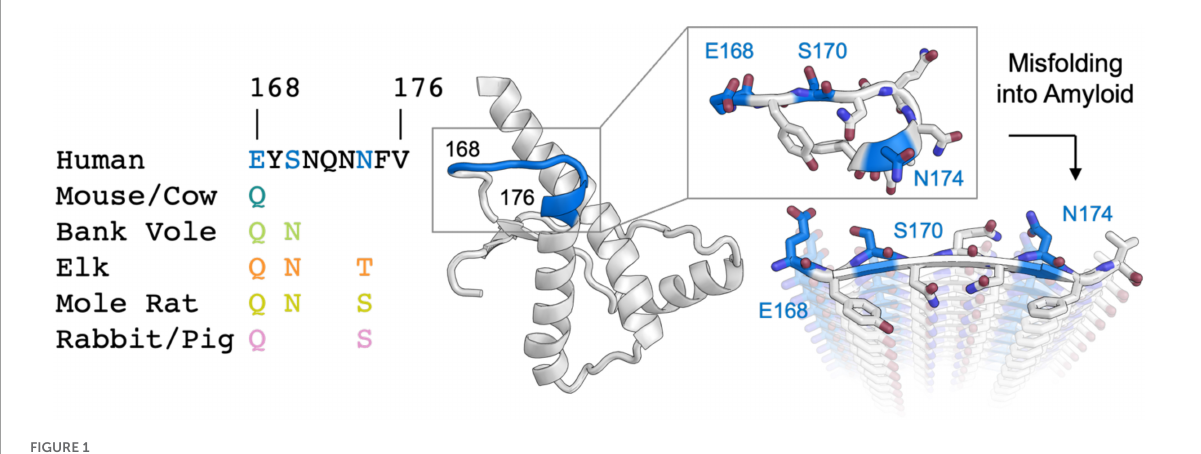
FIGURE1 Analysis of sequence variability in polar residues of the β 2 α 2 loop of the mammalian prion protein. The β 2 α 2 loop of mammalian prions (left) takes on a loop structure in PrP C (center and top right) but misfolds into a beta sheet amyloid conformation (bottom right) . Residues that vary between mammals (168, 170, and 174) are colored. Human PrP C structure with PDB ID 1QLX (Zahn et al., 2000) is shown.